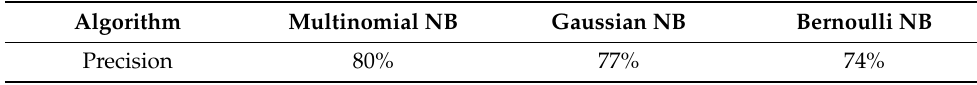
Table 1. Precision for the Republican data set.